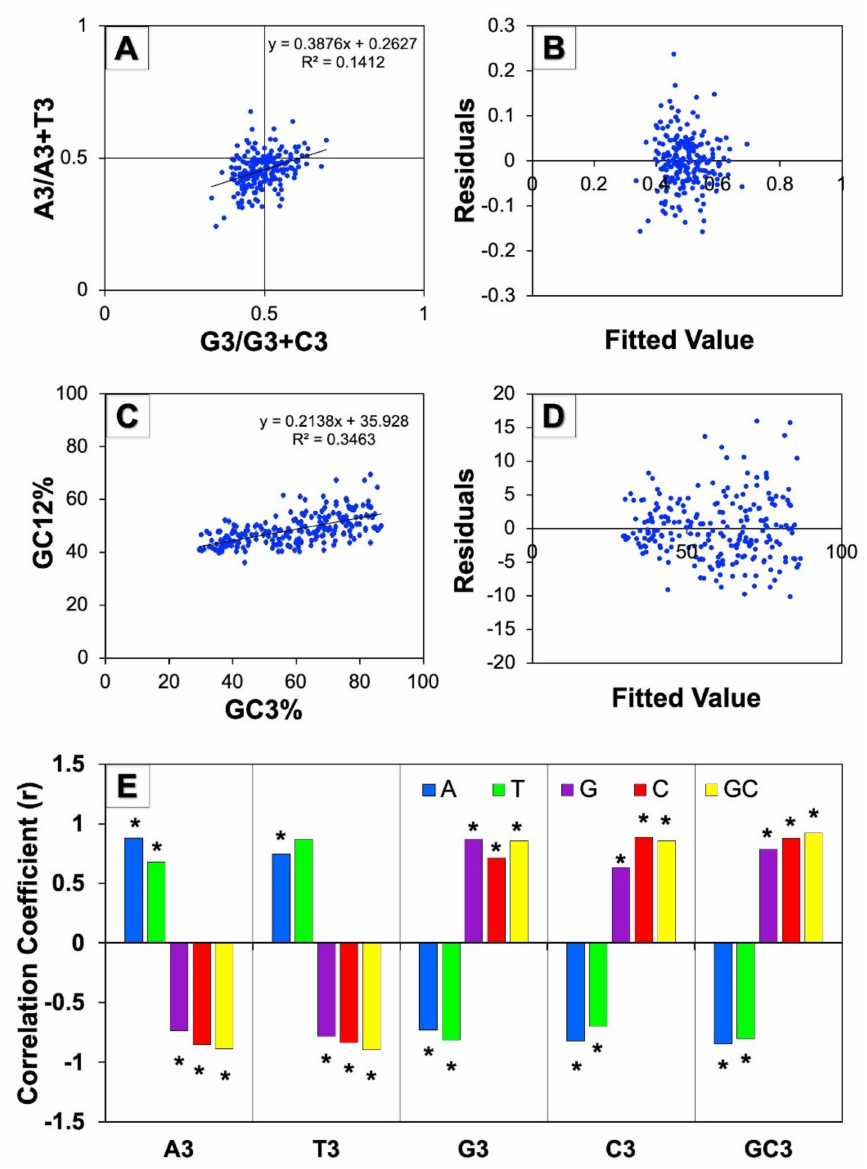
Figure 4. Influence of evolutionary forces on CUB of human autophagy genes. ( A ) represents the parity rule 2 bias analysis of human autophagy genes showing disproportionate distribution of GC and AT, while ( B ) is the residual plot for analyzing this regression model; ( C ) represents the neutrality plot analysis between GC12 (average of GC1 and GC2) and GC3 for all the 224 human autophagy genes, while ( D ) is the corresponding residual plot. ( E ) represents the correlation between overall nucleotide composition and nucleotide composition at the third codon position (* indicates p <